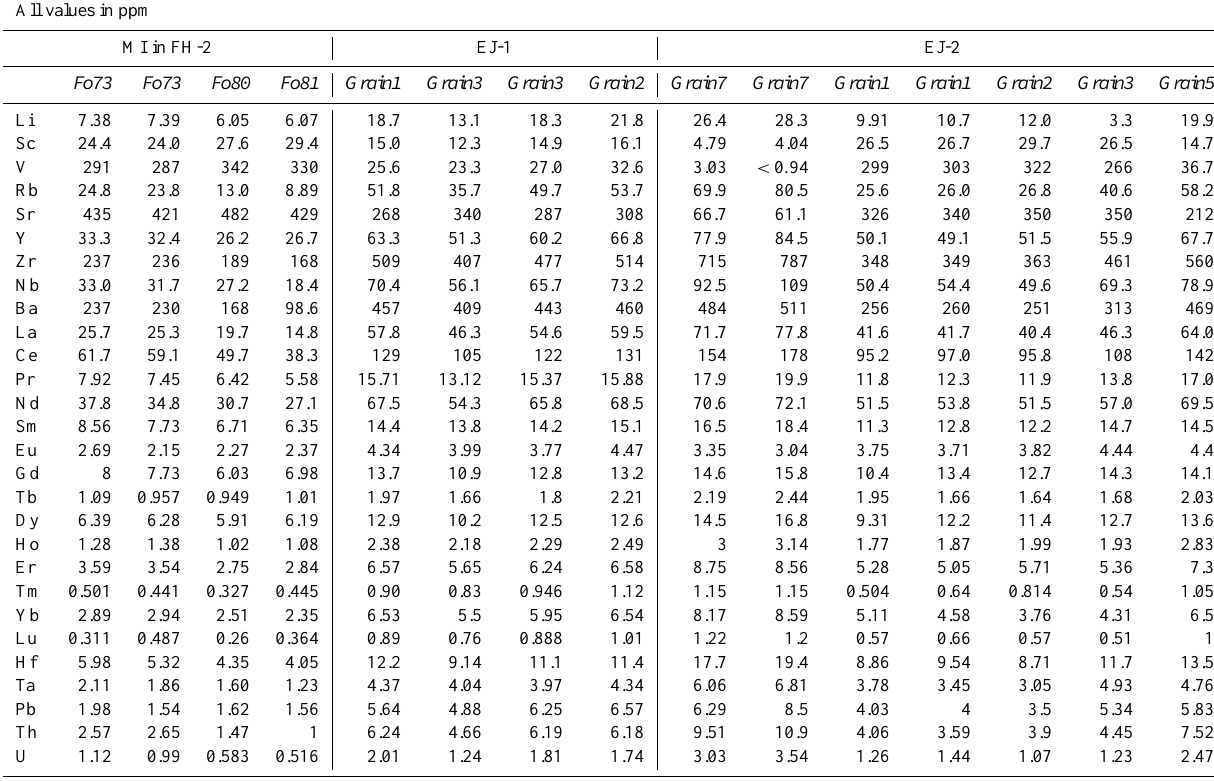
Table 3. Trace element concentrations analysed by laser ablation ICP-MS in melt inclusions (MI) in olivines from flank basalt and in benmoritic tephra erupted from the first explosive